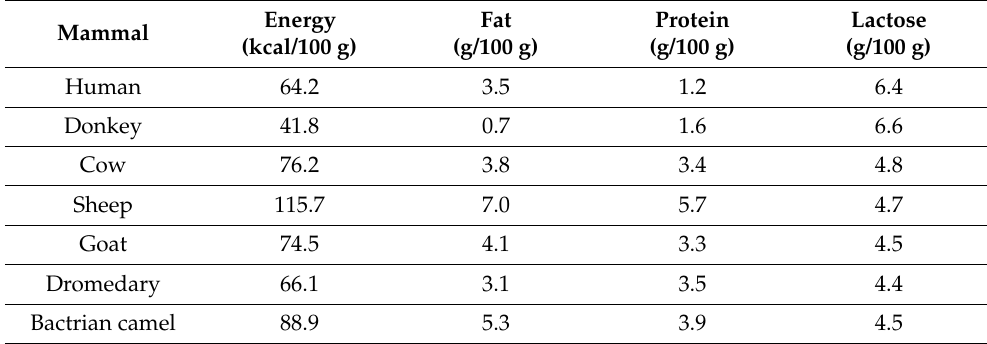
Table 1. Milk chemical